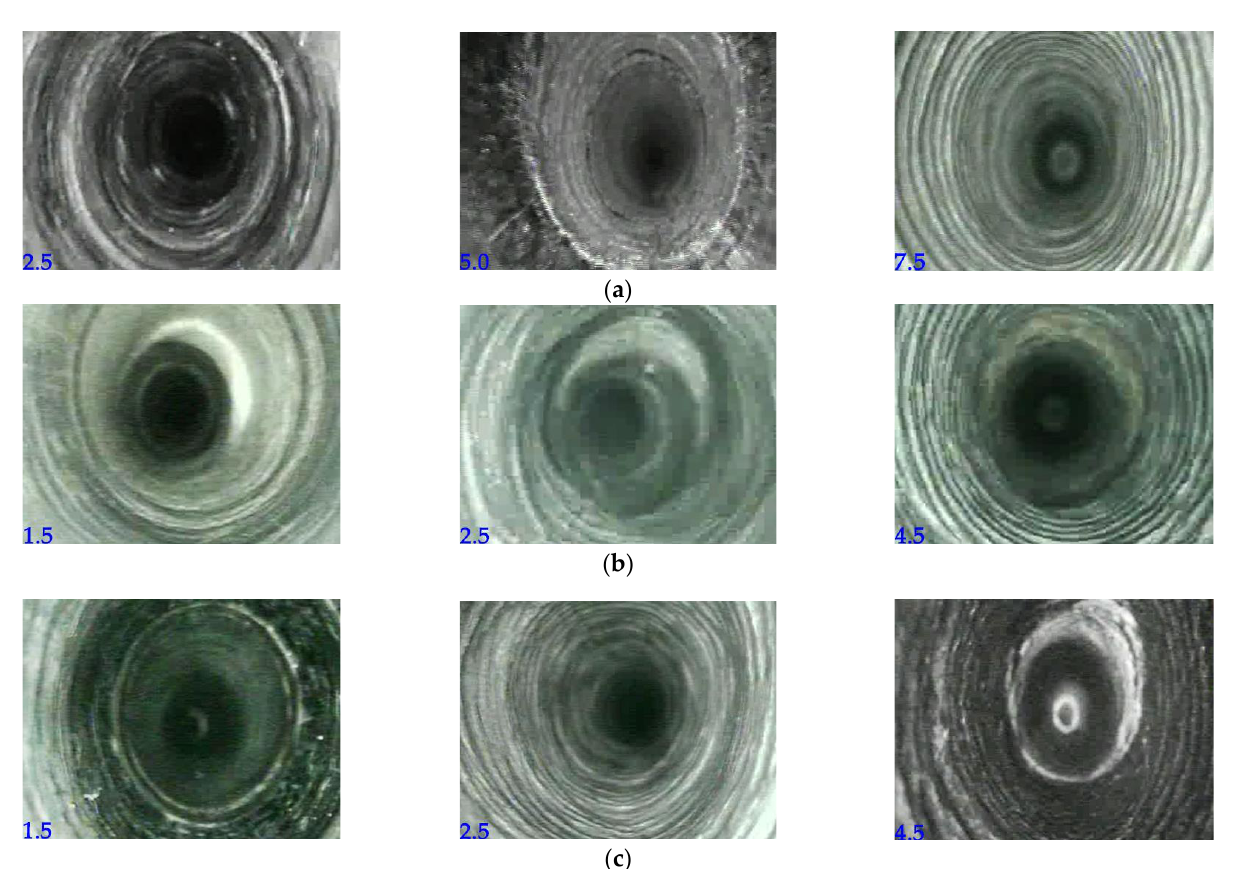
( c ) Figure 11. Surface displacement of the main roadway obtained by field observation: ( a ) #1 station curve; ( b ) #2 station curve; ( c ) #3 station curve. 6. Conclusions Using a case study of the KCM (Fuyang, China), we analyzed its − 967 m level west- wing main track roadway, as a typical 1 km deep large-section roadway. The results ob- tained made it possible to draw the following conclusions: (1) Field measurement of the in-situ stress in the study area revealed that the in-situ stress state was dominated by the horizontal in-situ stress, showing typical structural stress